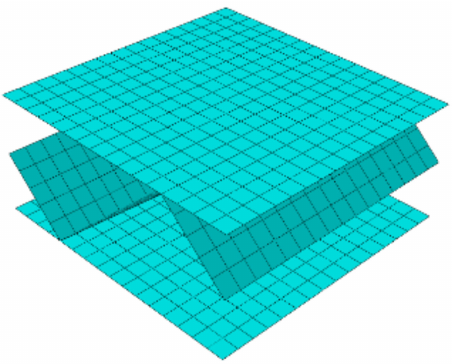
Figure 4. Representative shell elements of saw tooth geometry with quadrilateral mesh (single